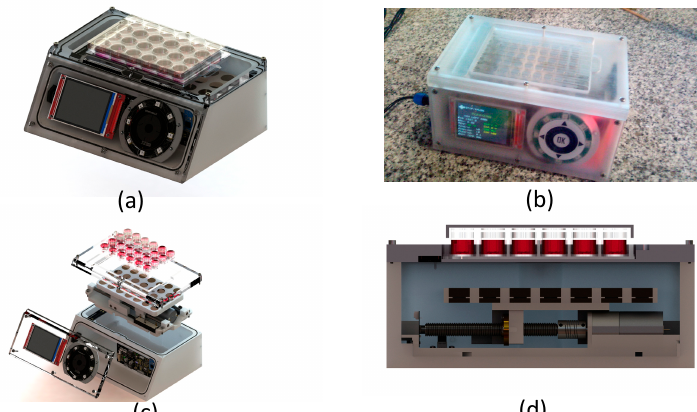
Figure 3. ( a ) Representation of the bioreactor assembled with a cell culture plate; ( b ) Bioreactor prototype built mechanism with every component; and schematic representation of ( c ) all disassembled main electric and mechanical components and ( d ) of the mechanical component represented as a transversal cut.